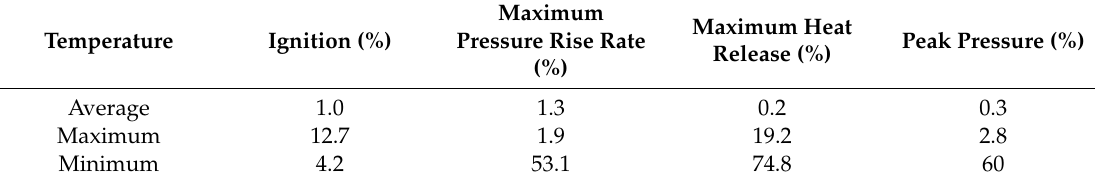
Figure 9. Comparison of series 2.